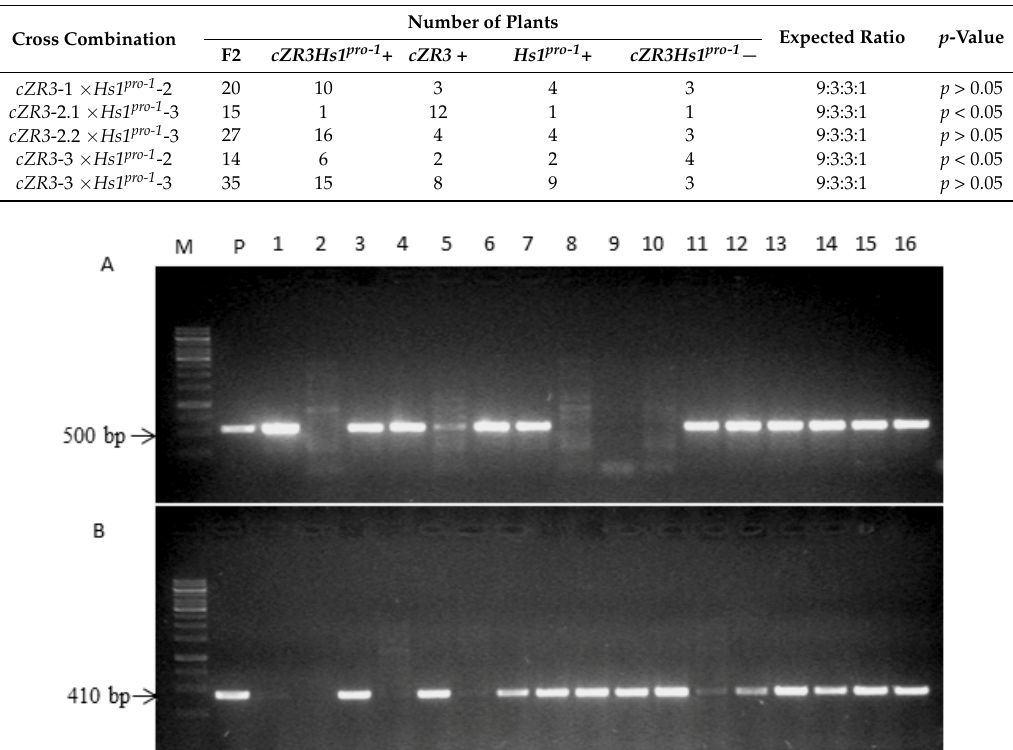
Table 2. Segregation ratios in the F2 generation derived from a cross between homozygous transgenic Hs1 pro-1 and cZR3 plants.